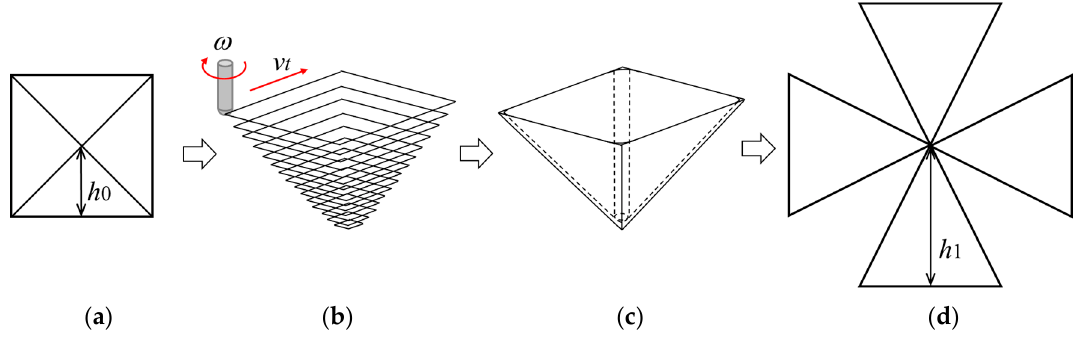
Figure 5. Forming of a square pyramid: ( a ) square blank to be formed; ( b ) tool path; ( c ) formed pyramid; ( d ) development view of a square pyramid.